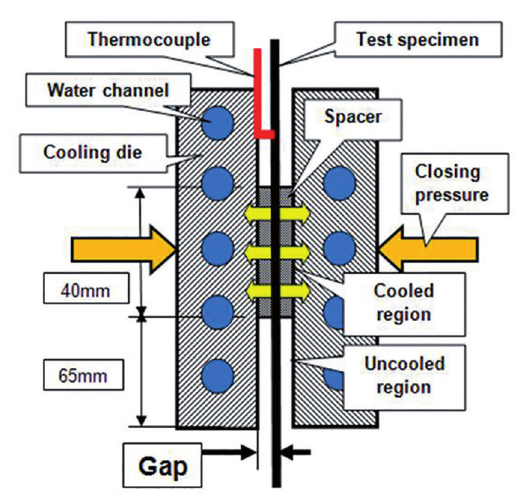
Figure 3: Detail of the experimental arrangement for cooling of the